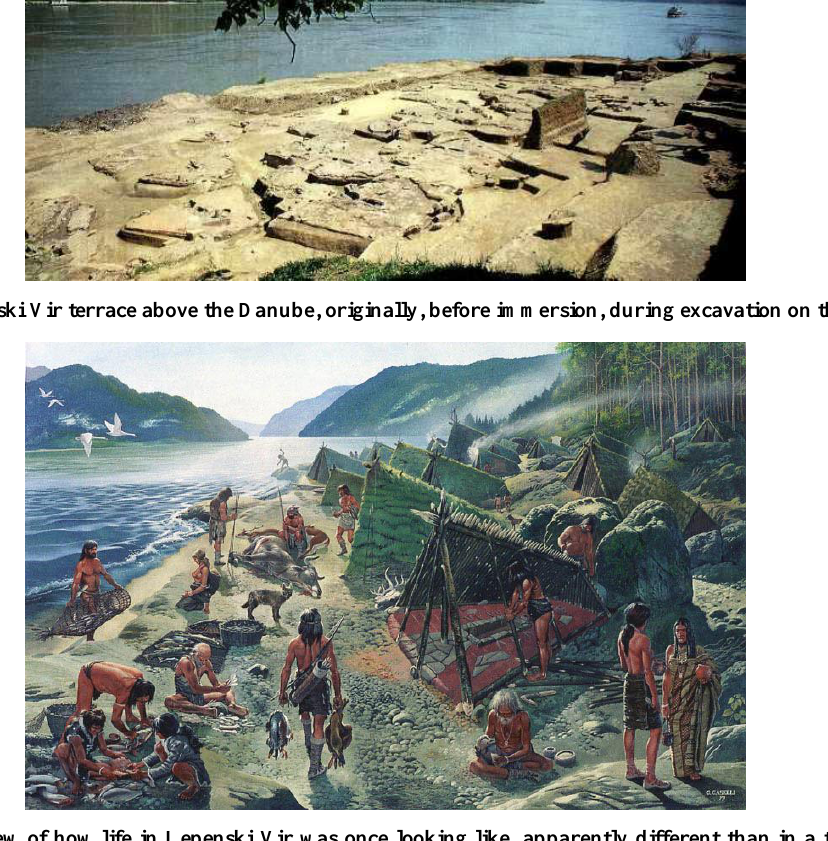
Figure 19. An overview of how life in Lepenski Vir was once looking like, apparently different than in a tourist resort as shown here at the end of this paper, with new technologies and materials, along with building machines. Perhaps, if they could, the inhabitants of Lepenski Vir also made bigger houses for themselves, but the technologies, materials and structures available at the time did not have the capacity to enable so. The project of the tourist village for 21st Century is an improvement, but not a change in the true essence. What could be improved, it was improved, but every time needs its art, and its own